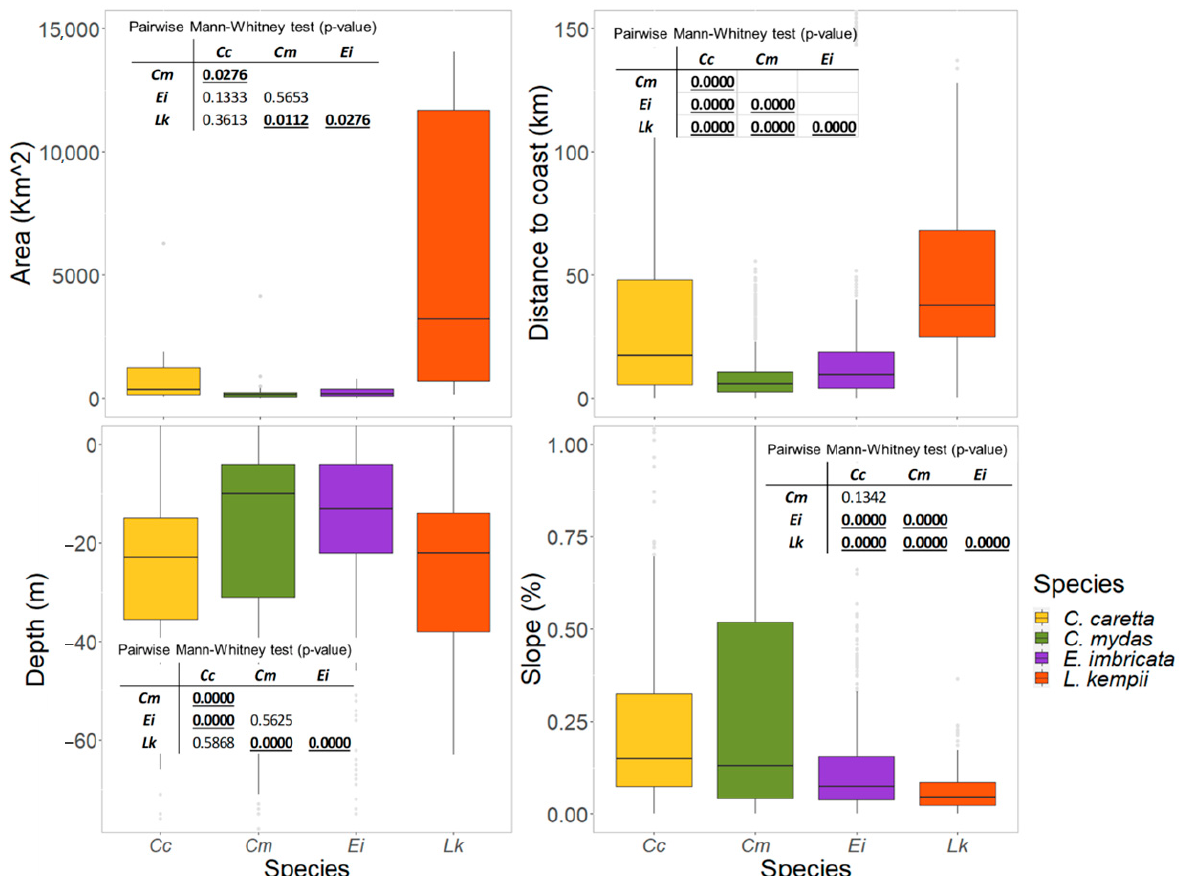
Figure 7. Physical variables for feeding and residency home ranges of the post-nesting sea turtles of four distinct species satellite-tracked from their nesting beaches at the Gulf of Mexico and West Caribbean. A pairwise Wilcoxon Rank Sum hypothesis test is presented as inset table for comparisons between species.